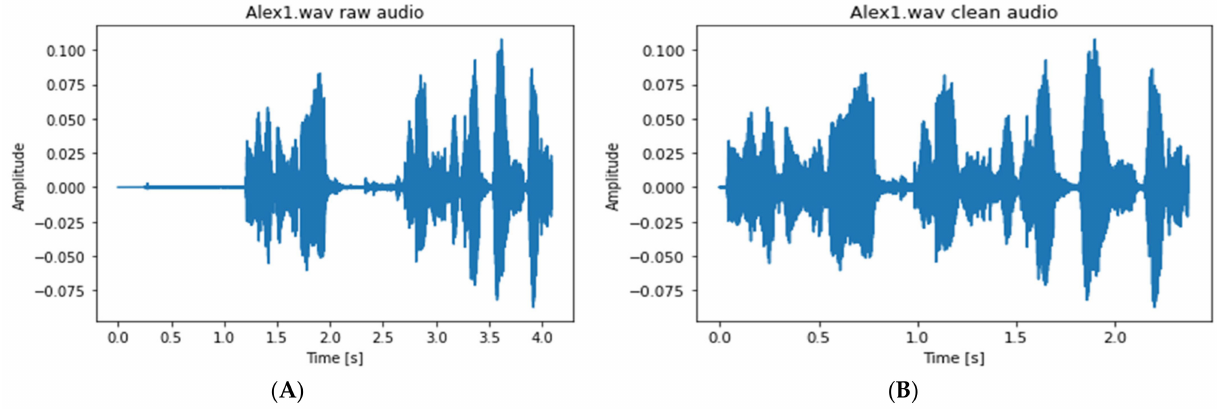
Figure 2. ( A ) A representative raw audio file from the speaker, Alex, before thresholding. ( B ) A representative clean audio file from the speaker, Alex, after